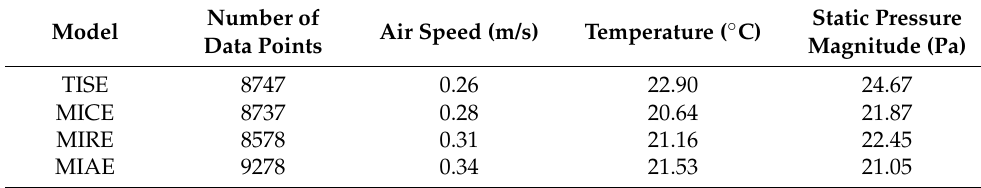
Table 5. Means of environment parameters at Plane I in four models. Note all the differences are statistically significant (ANOVA and subsequent Tukey’s test, p < 0.01) in this table.